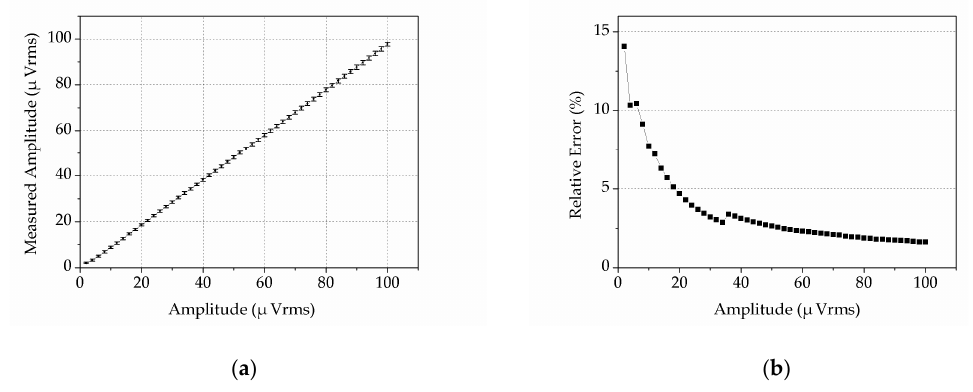
Figure 13. Weak signal detection using the DLIA. ( a ) Measured amplitudes versus the setting values. ( b ) Relative error of the measured amplitude. The two drops were caused by the amplification gain change.